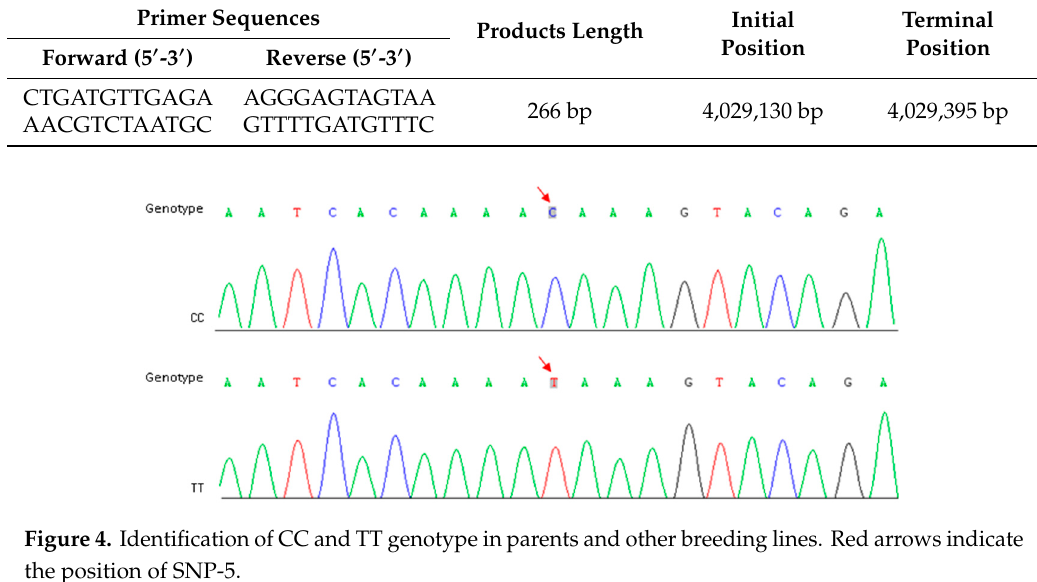
Table 3. Sequences of the primers used to amplify the fragment flanking SNP-5.